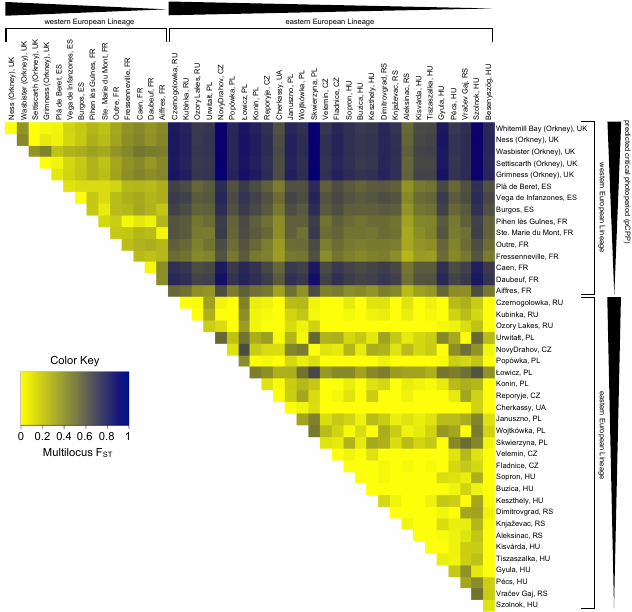
Figure 3. Pairwise multilocus F ST heatmap for Tshr haplotypes. F ST values were calculated using the original method for estimation of genetic distance with correction for sample size bias [70]. Colors indicate pairwise multilocus F ST values ranging from 0 (yellow) to 1 (dark blue). Western and Eastern European populations are ordered from long to short predicted critical photoperiods (pCPPs). 3.1. Western European Lineage In total, 43 SNPs (22 intronic and 21 exonic) were found in the Western European populations, of which 5 were non-synonymous and 16 were synonymous (Figure 4 and